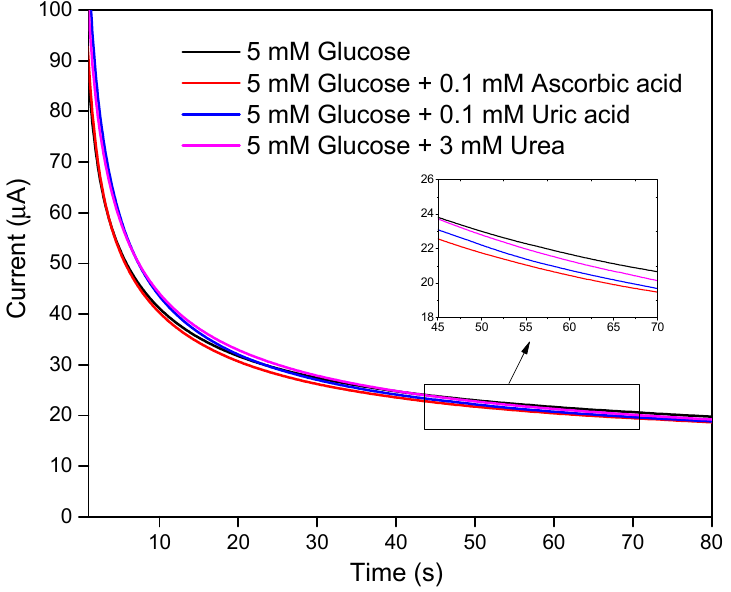
Figure 7. Chronoamperograms of 5 mM glucose with/without interferences. The inset shows the zoomed part of the result from 45 to 70 s.